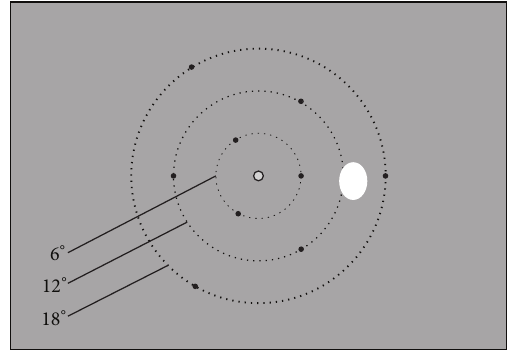
Figure 1: Stimulus grid showing the nine test locations (black dots) on the three concentric grid lines at 6 ∘ , 12 ∘ , and 18 ∘ (not visible in actual test), the central fixation point, and the reference location of the blind spot (white oval).